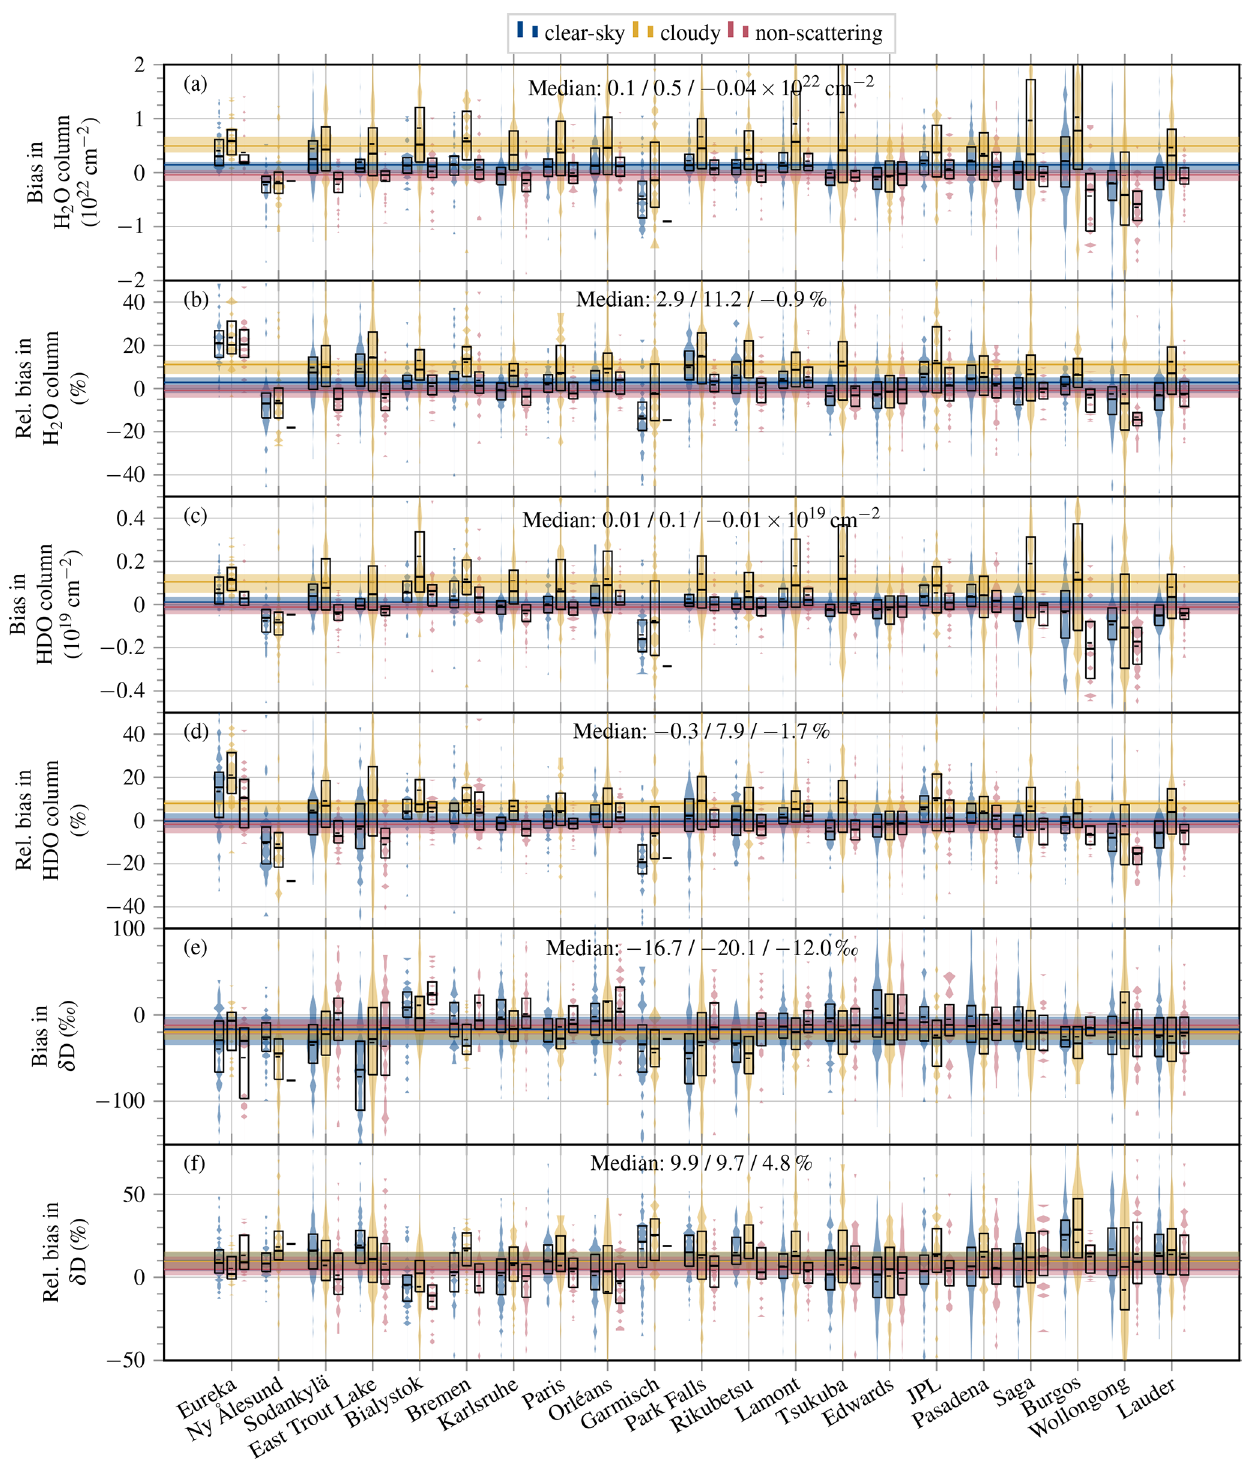
Figure 9. (a) Bias in H 2 O columns, (b) relative bias in H 2 O columns, (c) bias in HDO columns, (d) relative bias in HDO columns, (e) bias in δ D, and (f) relative bias in δ D for clear-sky scenes (blue), cloudy scenes (yellow) and the non-scattering retrieval (red). The violin plots visualise the distributions of differences between TROPOMI and TCCON, the boxplots mark quartiles and the dashed lines inside the boxes mark the mean. Coloured horizontal lines denote station-to-station medians and the shading around them the station-to-station quartiles.